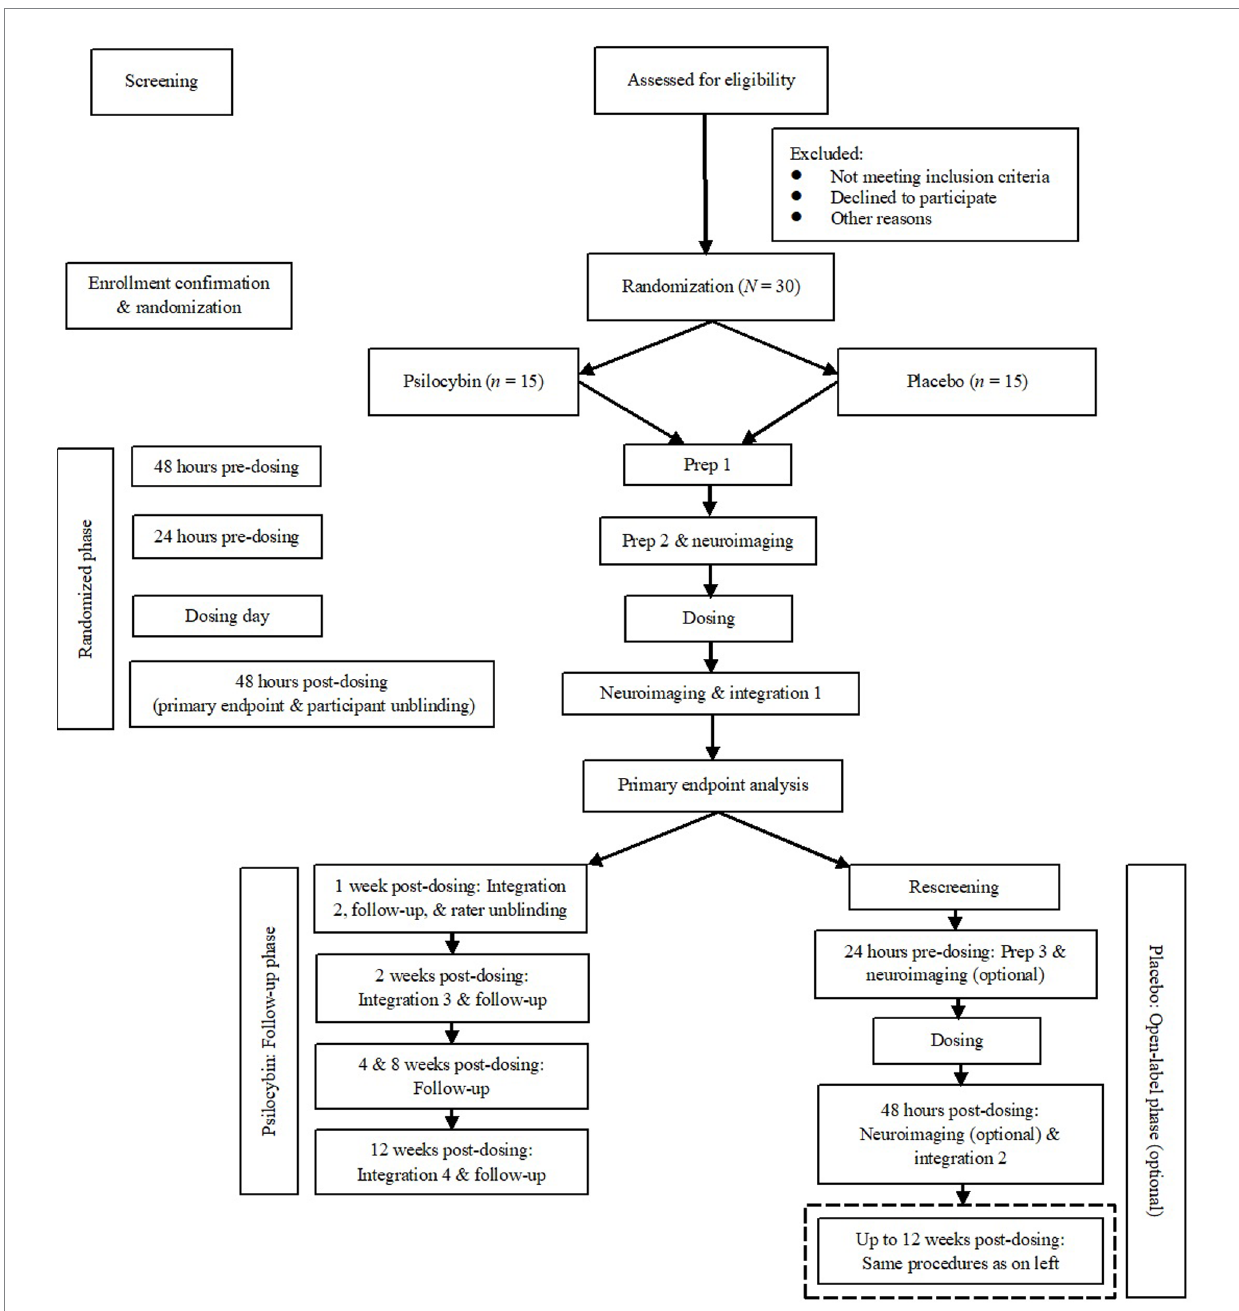
FIGURE 1 Simplified study flow